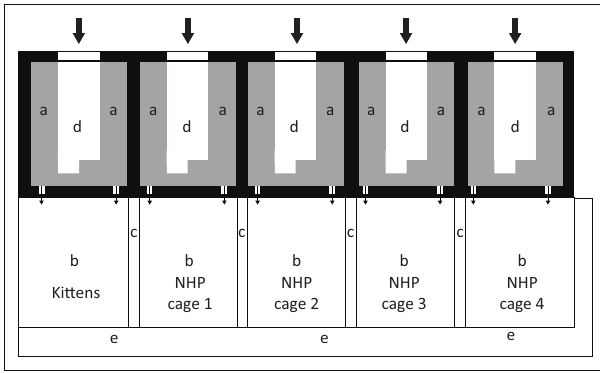
FIG URE 1: Cage layout for the cats and vervet monkeys. (a) inside cage area; (b) outside pens; (c) double fence separating the outer pens; (d) inside observation area; (e) outside observation area; thick arrow, room entry point; thin arrow, animal outer access hatches; large solid areas, bricked walls; thin line, expanded metal